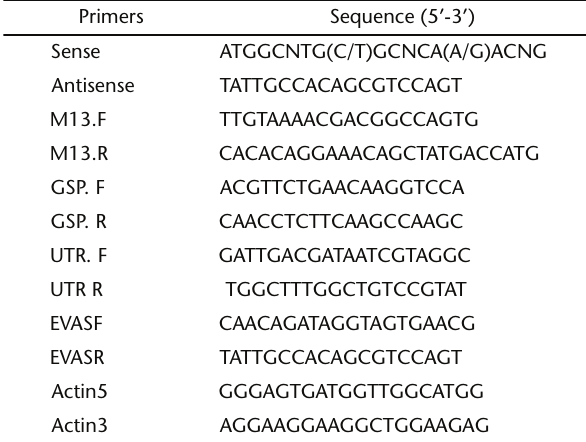
Table I Primers for PCR amplification and